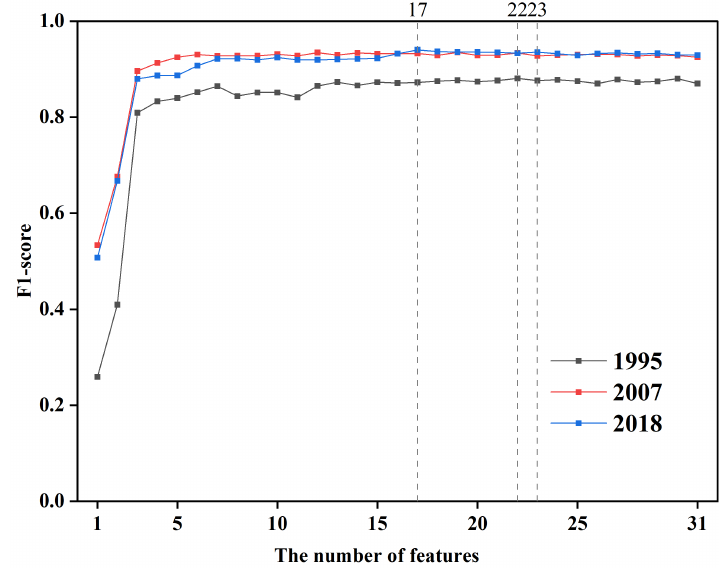
Figure 10. The change of F1-score curves of AG within the different selected